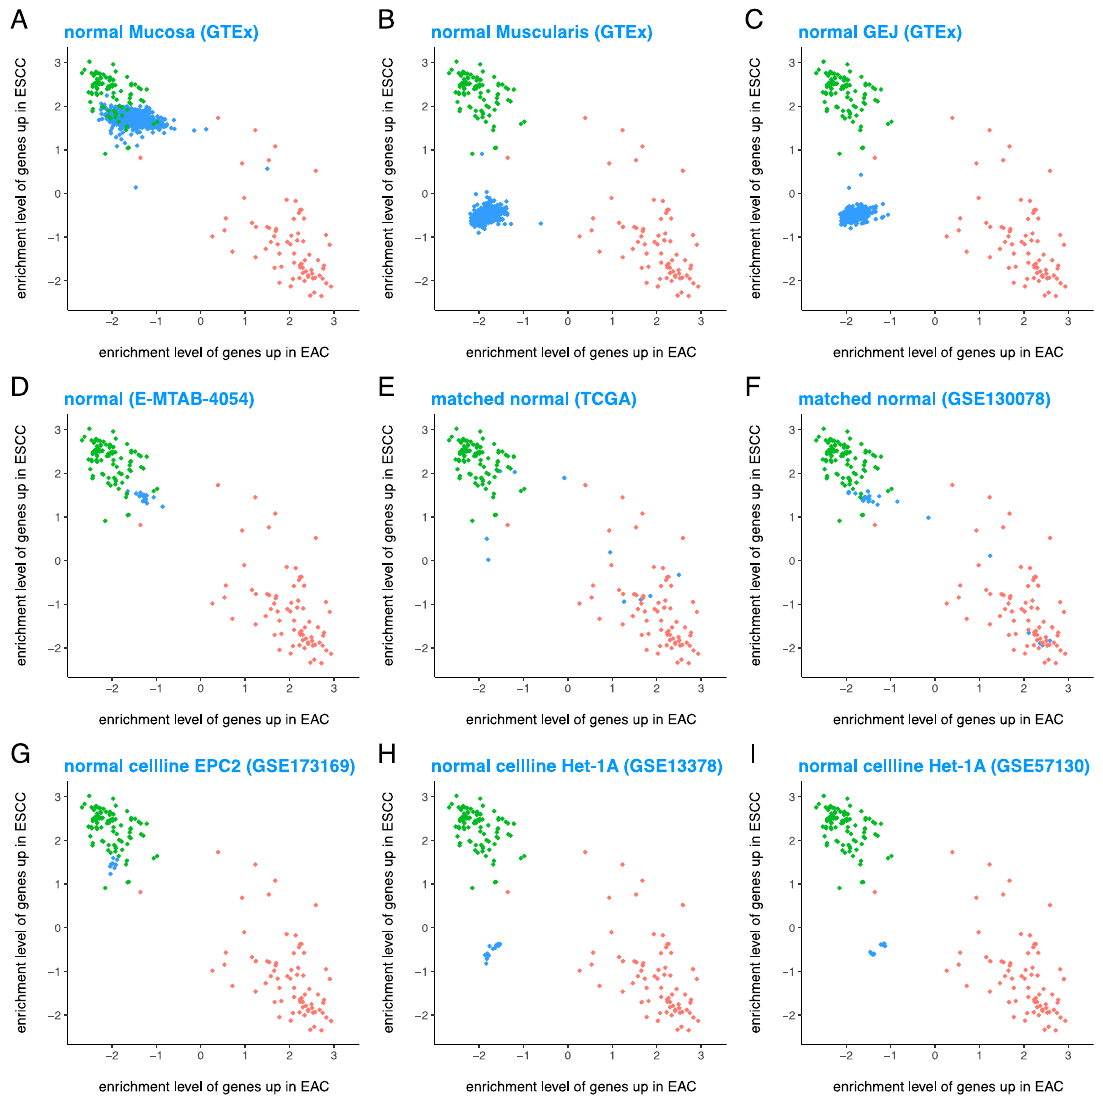
Figure 3. Normal esophageal cell lines are quite similar to tissues derived from various parts of the normal esophagus. Enrichment levels of 100 EAC hi and 100 ESCC hi genes show that ( A ) normal esophagus mucosa is ESCC-like, ( B ) normal esophagus muscularis and ( C ) normal gastro–esophageal junction are neither EAC-like nor ESCC-like, ( D ) normal squamous esophagus is ESCC-like similar to normal esophagus mucosa, ( E , F ) matched normal esophagus from esophageal cancer patients are all over the place, ( G ) normal esophageal cell line EPC2 is similar to normal esophagus mucosa (ESCC-like), and ( H , I ) normal esophageal cell line Het-1A is similar to normal esophagus muscularis and normal gastro–esophageal junction (neither EAC-like nor ESCC-like). Red = EAC cases from TCGA, green = ESCC cases from TCGA, and blue = test samples (various types of samples from datasets other than TCGA).